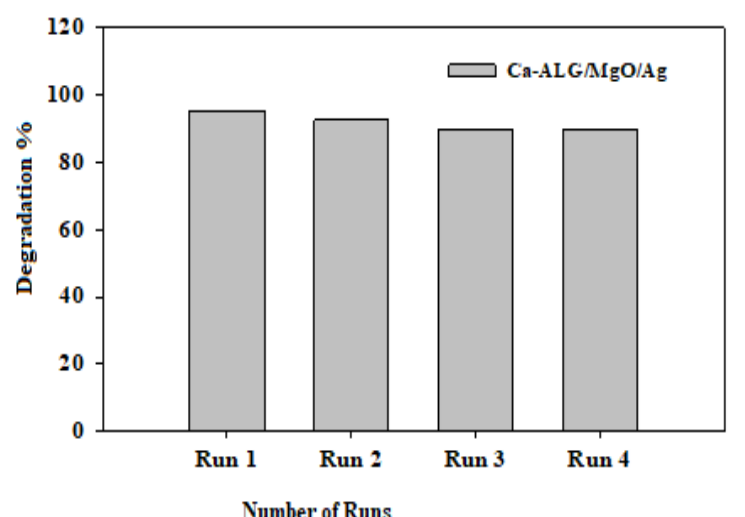
Figure 11. The reusability test of Ca-ALG/MgO/Ag nanocomposites as a catalyst for degradation of Direct Red 83 dye in four consecutive